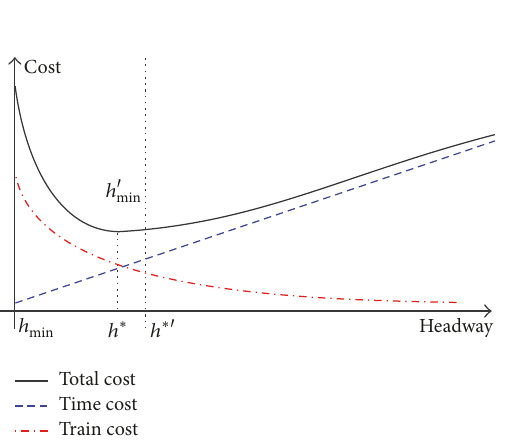
Algorithm 2: Rolling optimization algorithm.